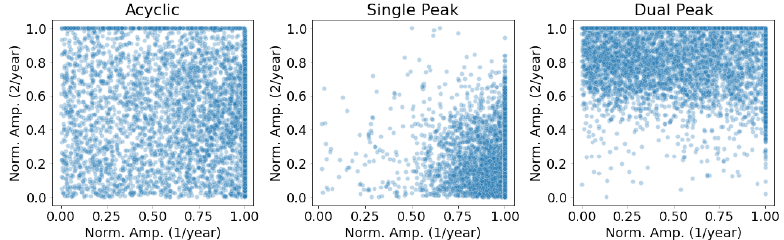
Figure 20. Comparing the normalized amplitude of the periodogram at a frequency of 1/year and